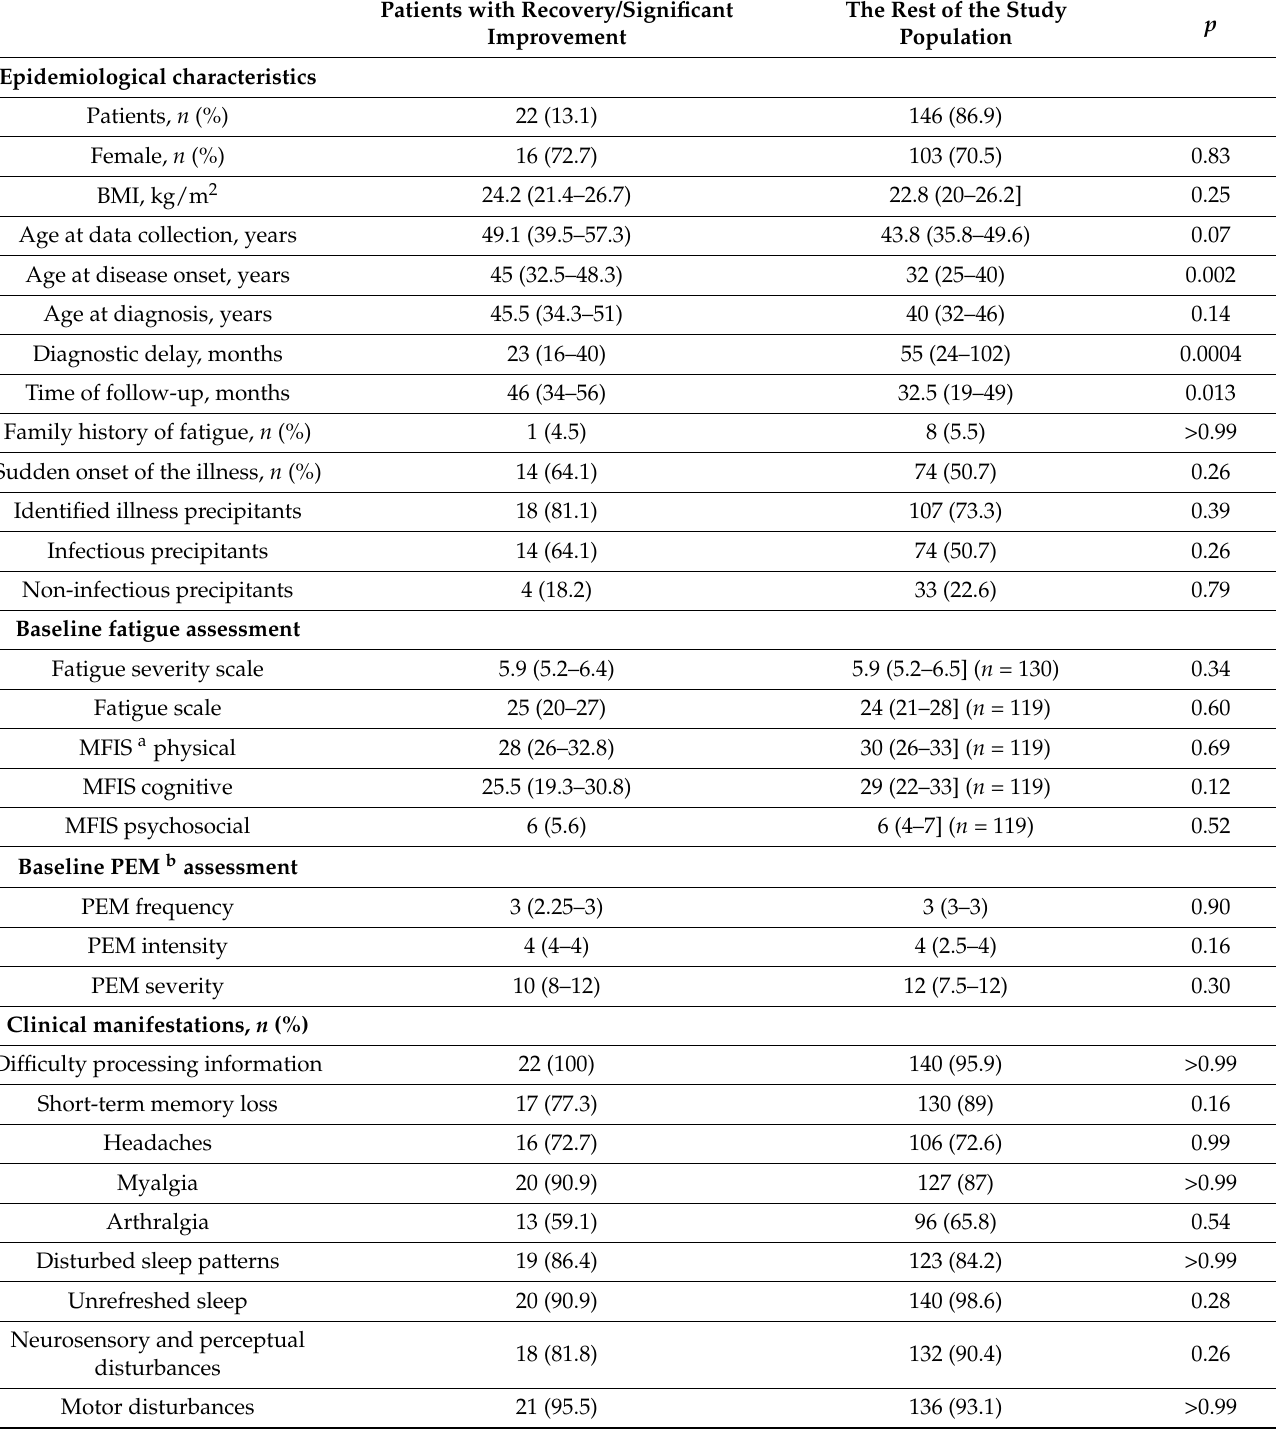
Table 1. Comparison between myalgic encephalomyelitis/chronic fatigue syndrome patients with and without recovery/significant